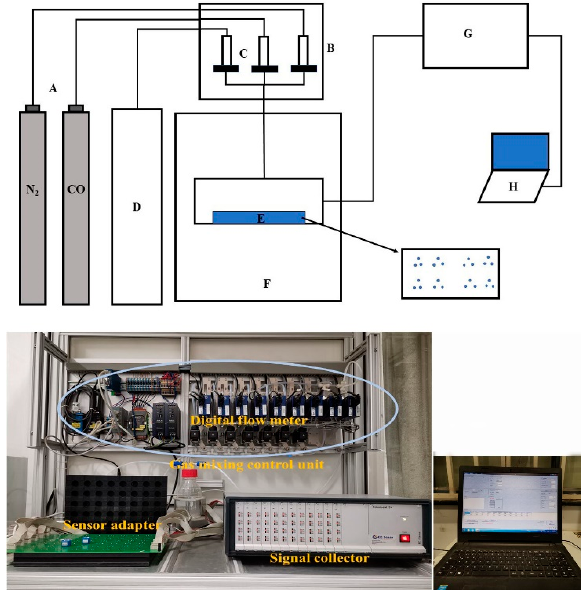
Figure 2. The schematic diagram of the sensor test system with the photos of gas mixing control unit, signal acquisition unit, computer control and storage unit. A: Gas cylinder, B: Gas mixing control unit, C: Digital flow meter, D: Clean air, E: Sensor adapter, F: Climate Chamber, G: Signal acquisition unit, H: Computer control and storage unit.